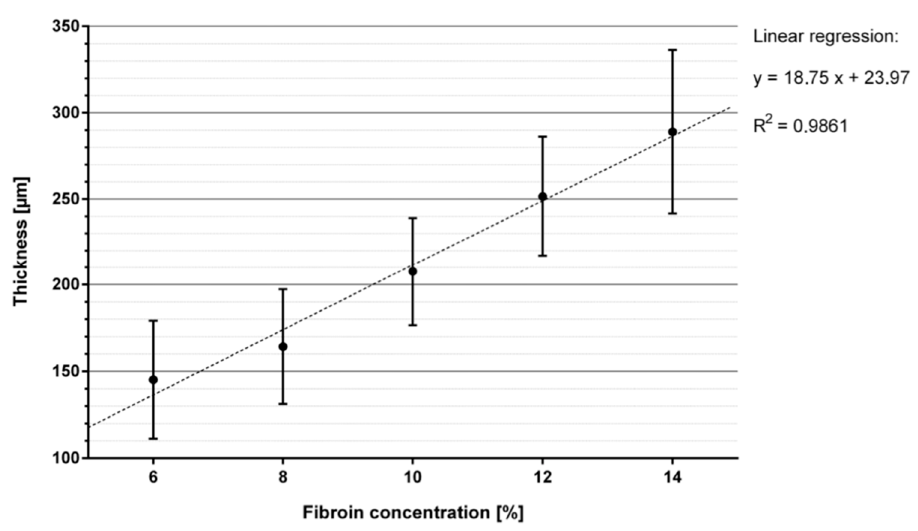
Figure 4. Mean value and standard deviation of membrane thickness with linear regression as a function of silk fibroin concentration.